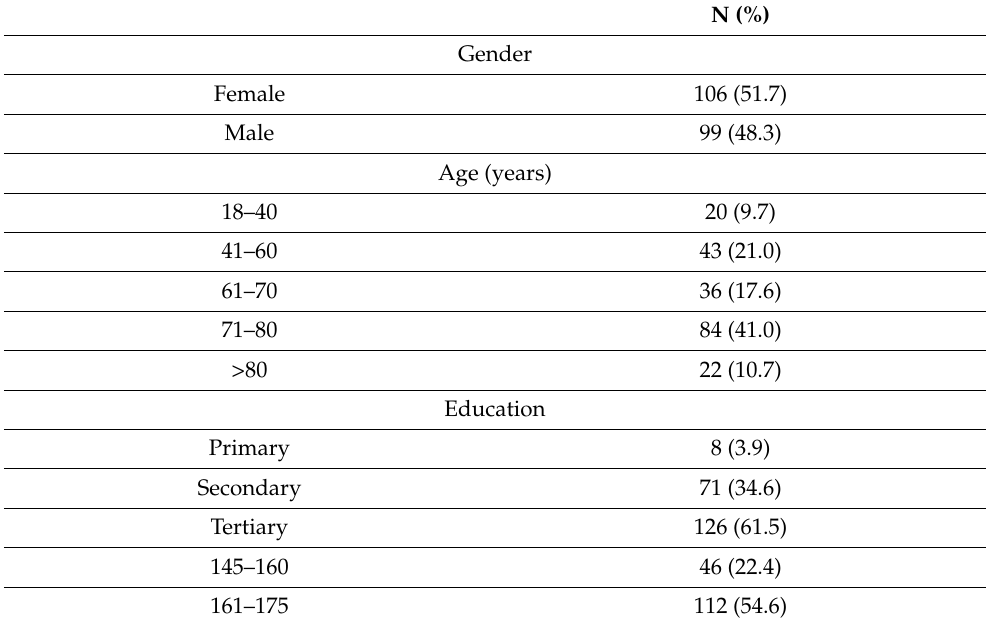
Table 1. Sociodemographic Characteristics (N =